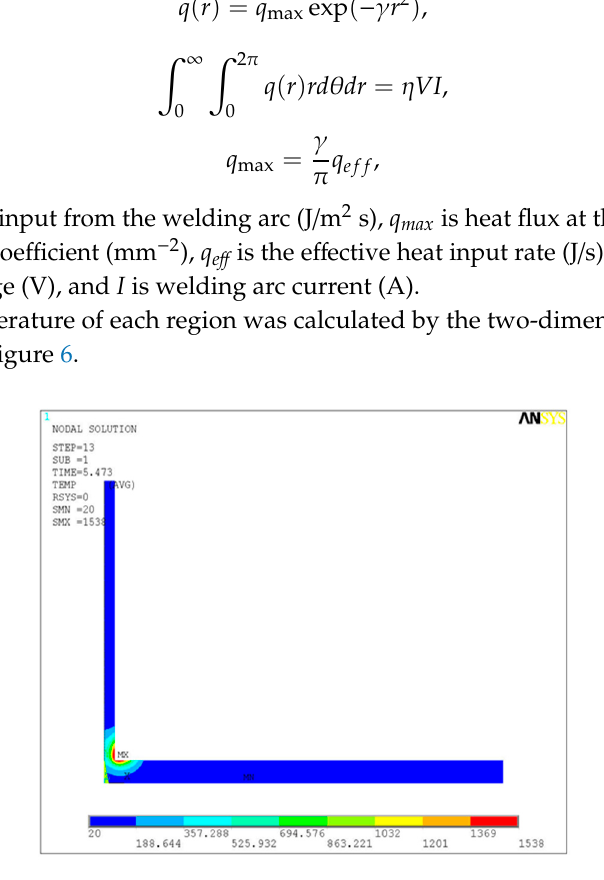
Figure 6. Heat transfer analysis (temperature distribution).